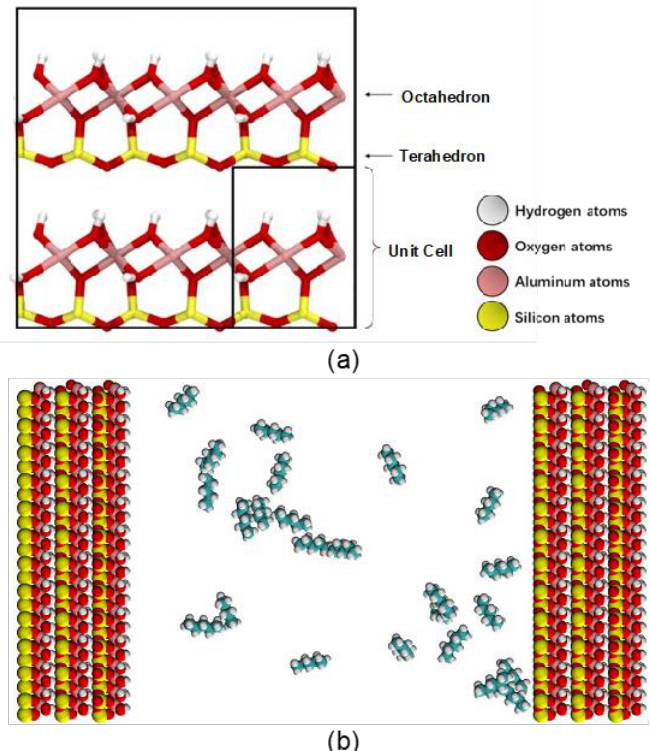
Figure 3. ( a ) A unit cell of kaolinite and ( b ) initial configuration of the kaolinite pore filled with 25 pentane molecules. Kaolinite, with aluminol surface on the left side and silicate surface on the right. The colors are stated here: white (hydrogen atoms), red (oxygen atoms), pink (aluminum atoms), yellow (silicon atoms), and green (carbon atoms).